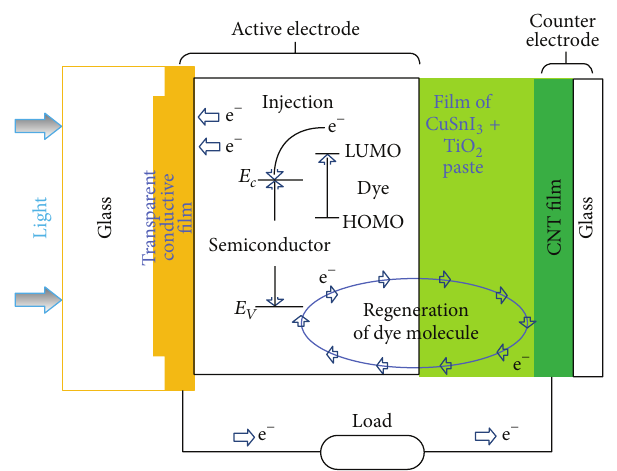
Figure 2: Schematic illustration shows the proposed dye sensitized solar